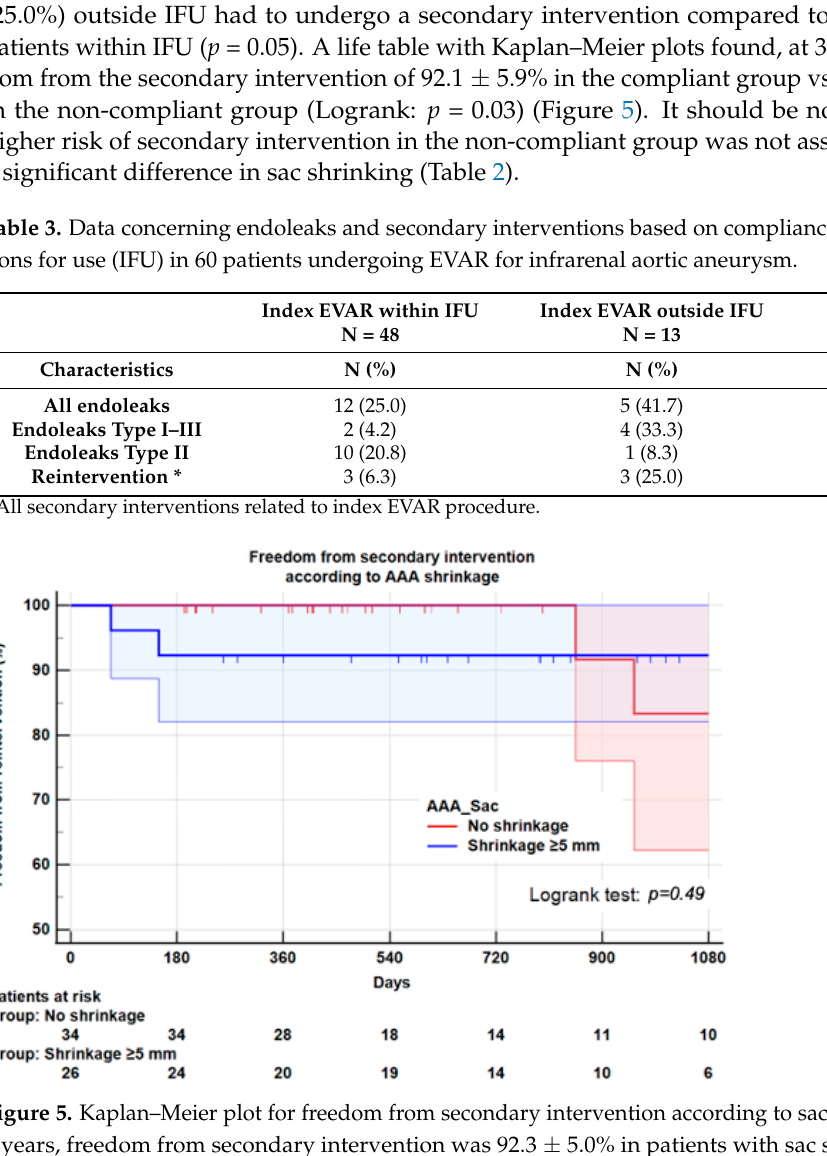
Figure 5. Kaplan–Meier plot for freedom from secondary intervention according to sac shrinkage. At 3 years, freedom from secondary intervention was 92.3 ± 5.0% in patients with sac shrinkage and 83.3 ± 9.0% in patients with no sac shrinkage, p = 0.49.